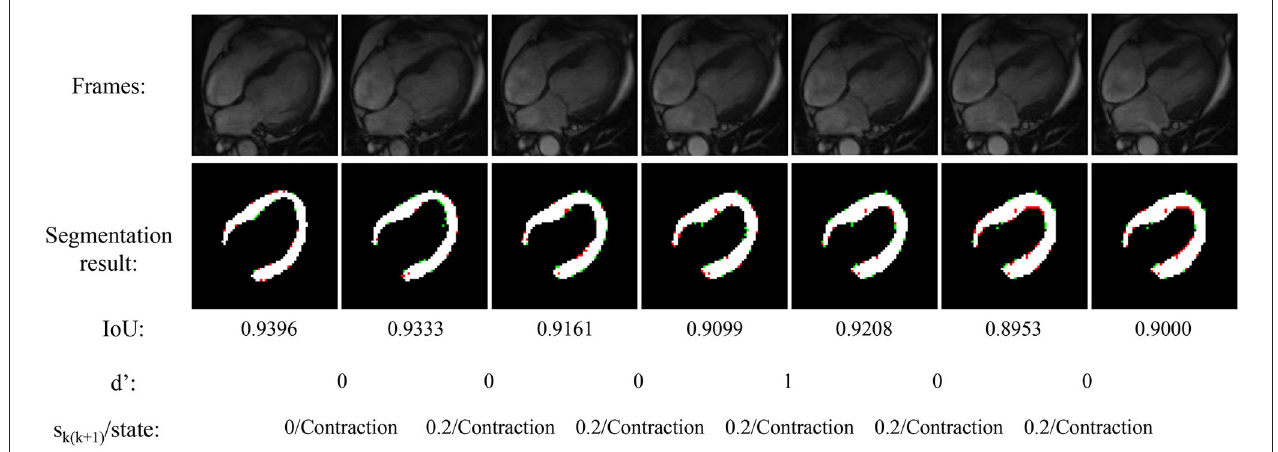
FIGURE 4 | Experimental result of the proposed method during cardiac contraction. Red points in segmentation result: undetected LV pixels. Green points in segmentation result: error-detected